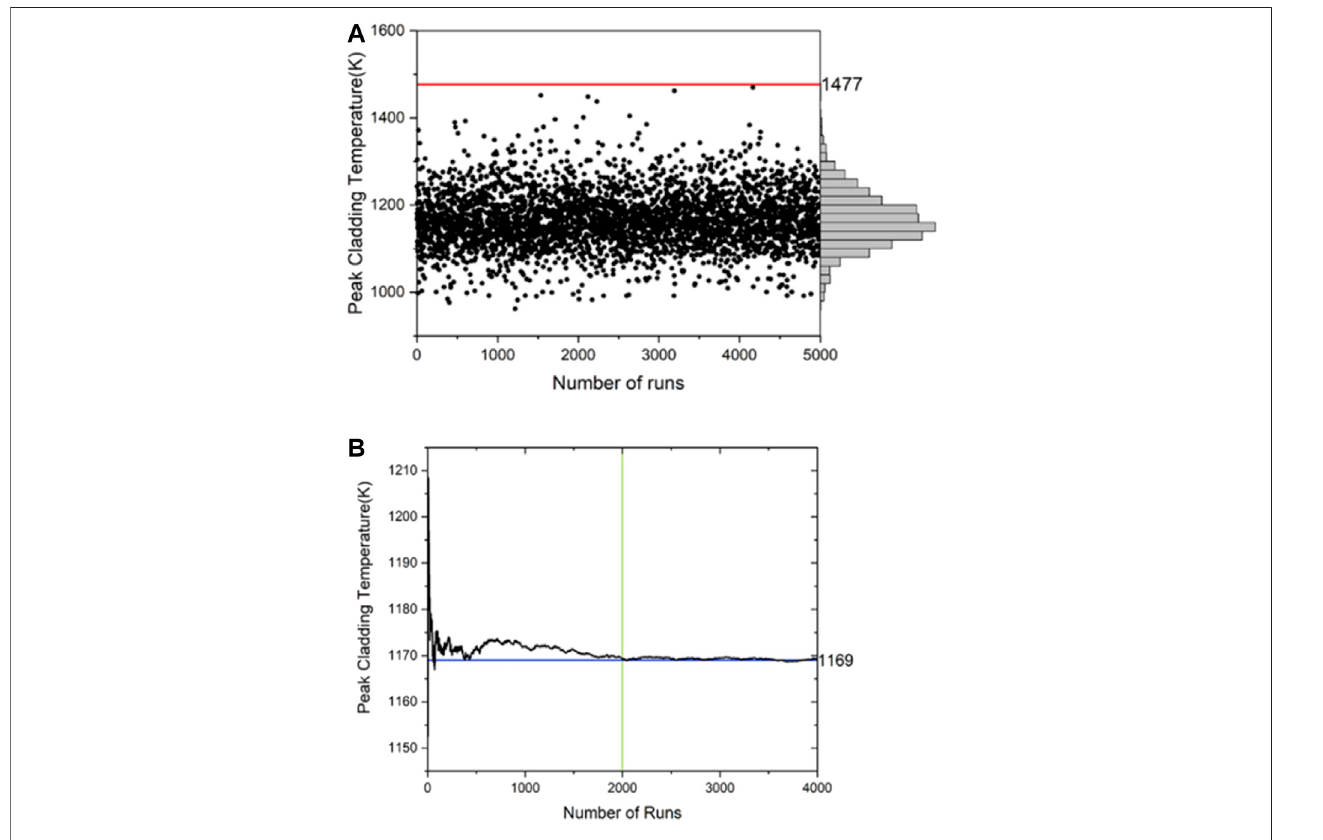
FIGURE 3 | PCT convergence (A) and scatter plot (B) vs. number of runs.